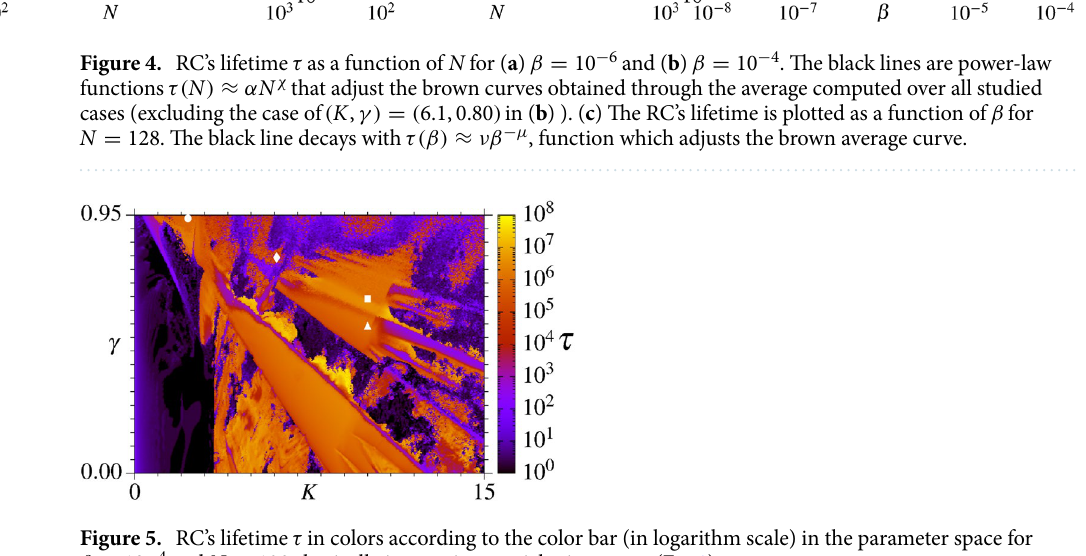
Fig. 1. The black line is the power-law regression fit of the brown averaged curve which decays with exponent µ = 1.02609 ± 0.00068 .